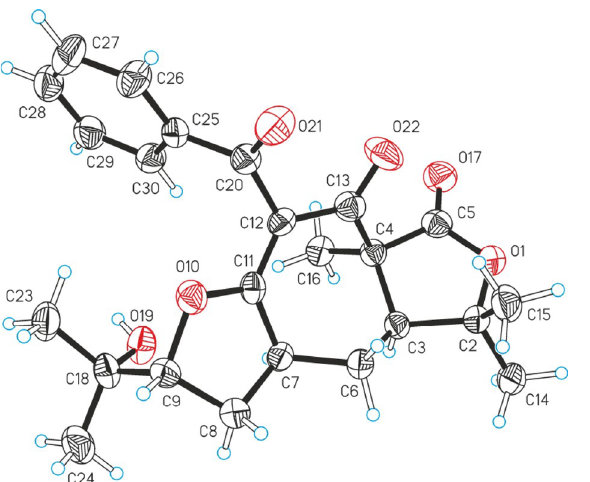
Figure 6. Molecular structure of 2 (non-H atoms are represented as thermal ellipsoids drawn at the 50%